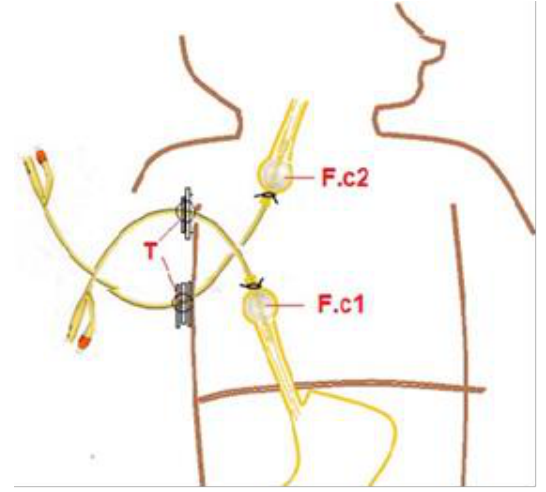
Figure 1: An illustration of the technique. F.c1 (Foley cathe- ter 1); F.c2 (Foley catheter 2); Pieces of traction tubes for incrementing tractions.